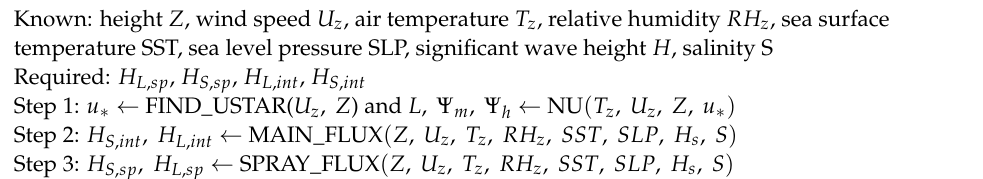
Algorithm 1. The process of calculating the air–sea heat flux by the YJ22